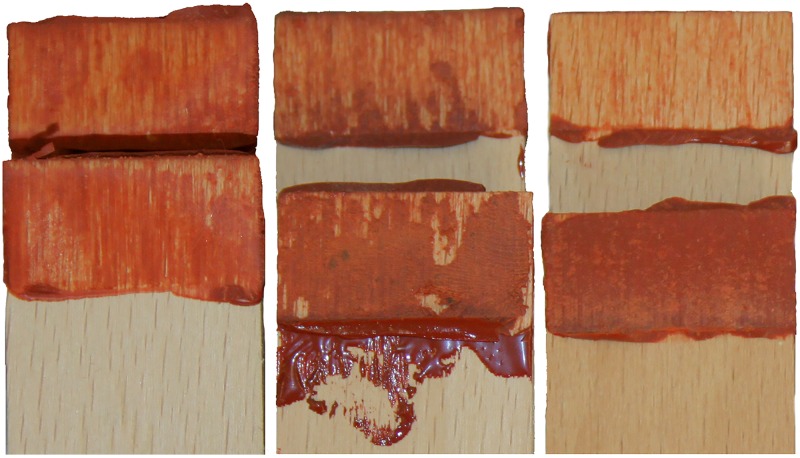
Example of failure modes through examination of the bonded surfaces after lap shear test completion.Left: cohesive (250 mg rosin/250 mg beeswax/50 mg ochre), the adhesive remains evenly bonded to both sides; middle: mixed-mode (400 mg rosin/100 mg beeswax/100 mg ochre), the adhesive favours one side, but remains bonded to both some areas; right: adhesive failure (400 mg rosin/100 mg beeswax/50 mg ochre), the adhesive remains bonded to one side only.